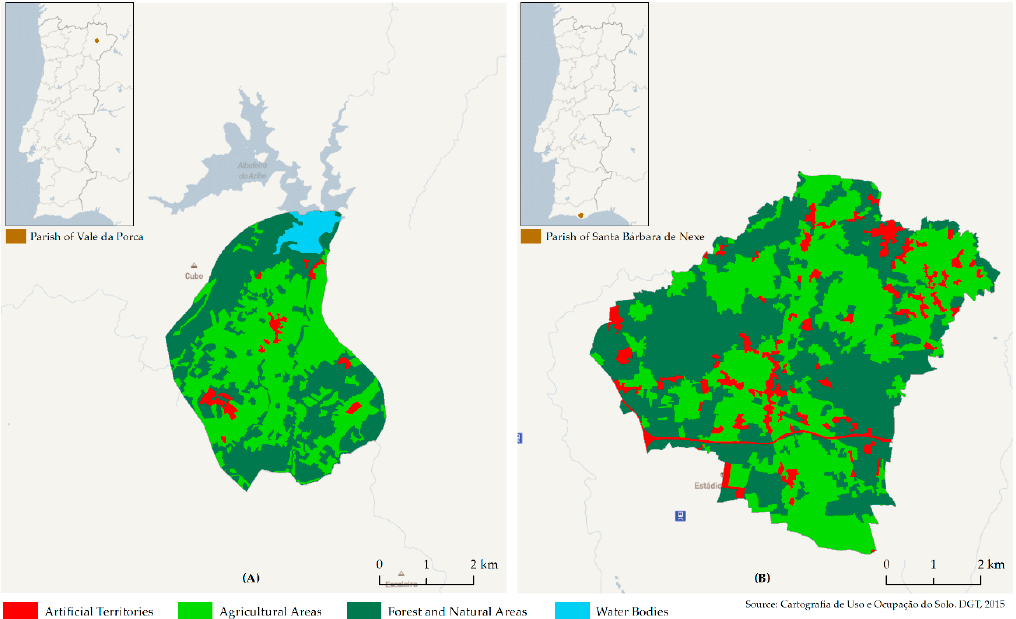
Figure 9. Land use in 2015 ( A ) Vale da Porca (TIPAU = APU and DEGURBA = 3); ( B ) Santa Barbara de Nexe (TIPAU = APR and DEGURBA = 1).